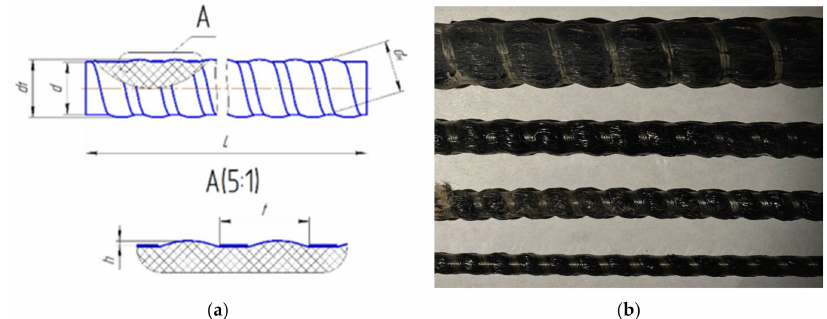
Figure 1. ( a ) The keys of periodic rebar profile, ( b ) samples of BFRP